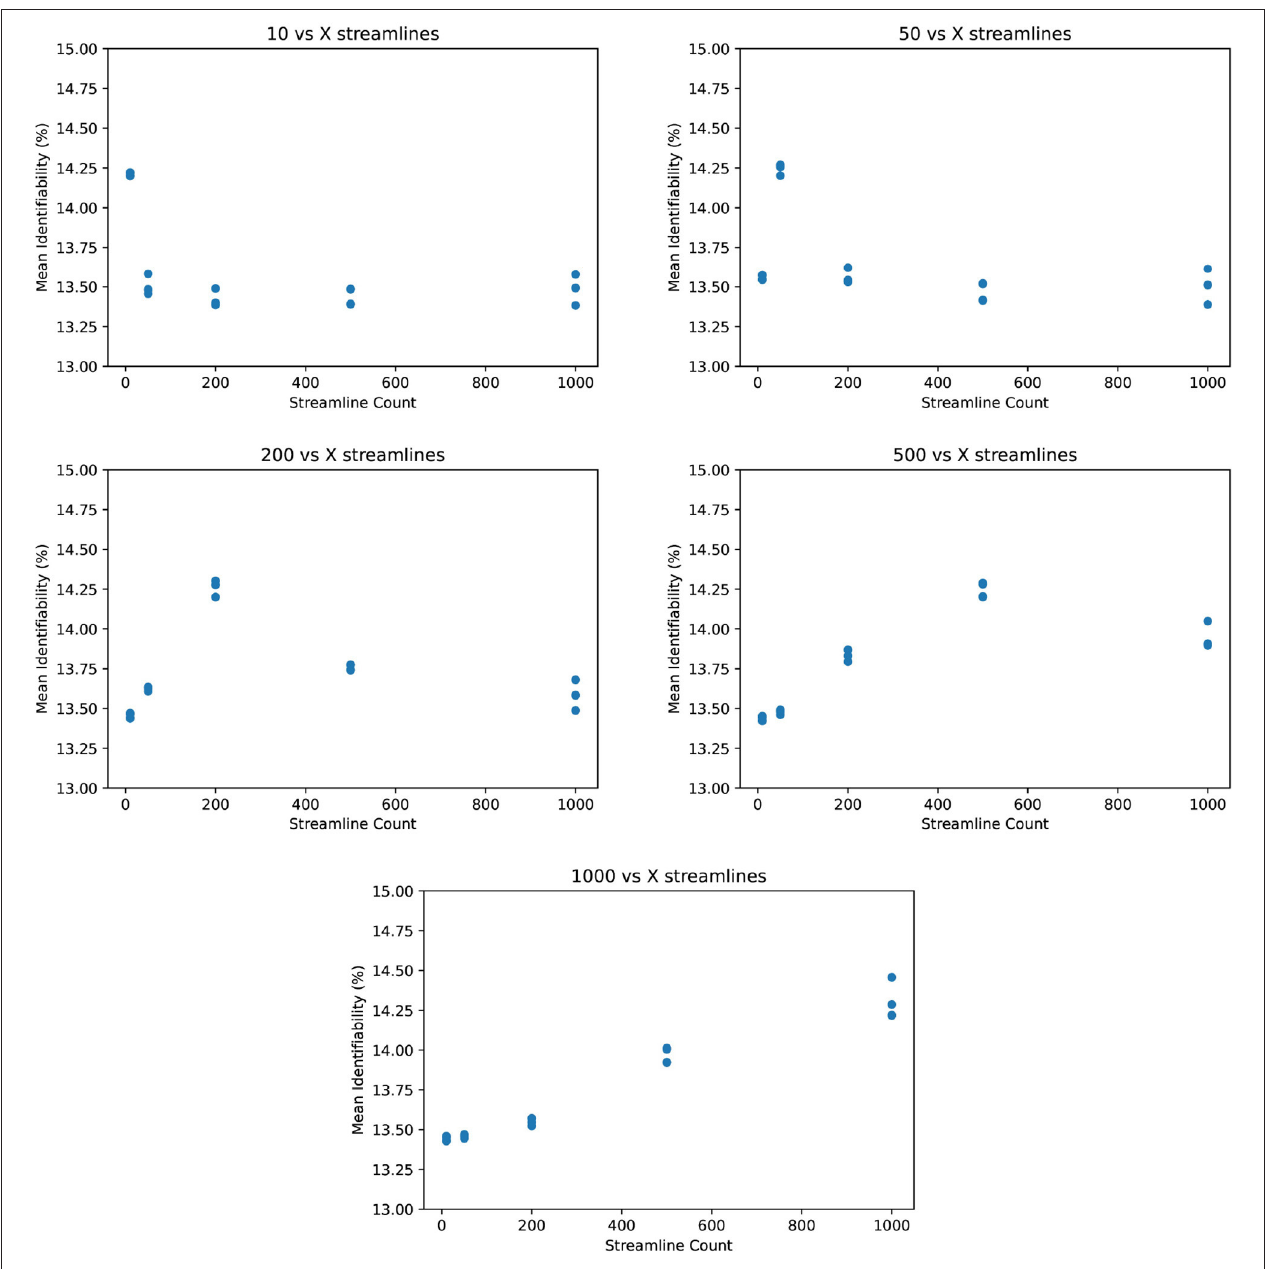
FIGURE 5 | Mean identifiability across streamline counts ( q = 4 random seeds per streamline count, k = 20 subset size, r = 10 repetitions).